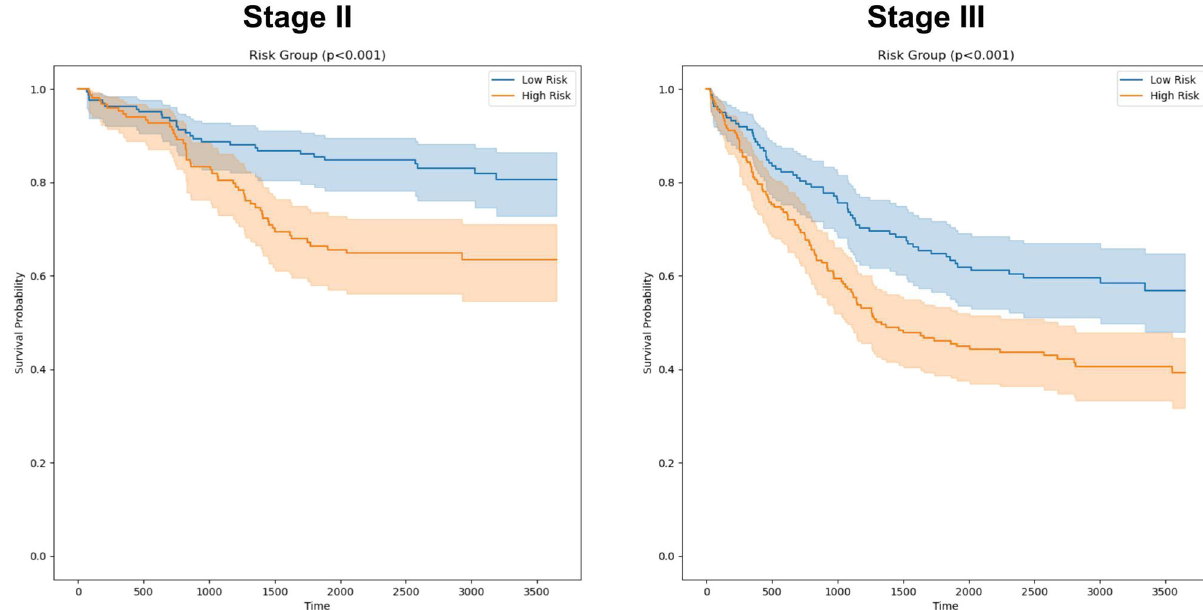
Fig. 3 Kaplan-Meier Curves for LNM risk groups (temporal validation set). Kaplan-Meier Curves for disease speci fi c survival (DSS) amongst stage II and stage III cases, respectively. A logistic regression model using the fi ve machine-learned features identi fi ed for LNM prediction was fi t on the development cohort for predicting DSS. Risk groups were de fi ned within each stage by binarizing using the median LNM model score for the most recent 5-years of the development cohort (2003 to 2007). The resulting regression models and risk group thresholds were then evaluated on the temporal validation set. The logistic regression model provided signi fi cant risk strati fi cation within both node-negative and node-positive disease groups, suggesting the potential of such a model to aid in improving prognostication and therapeutic decision